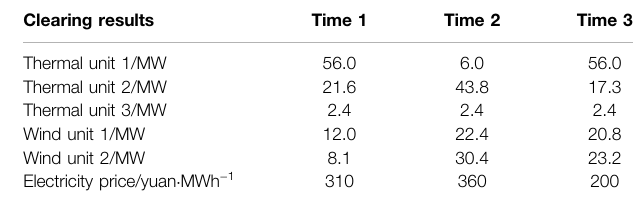
TABLE 5 | Market-clearing energy of the traditional model without considering security constraints.